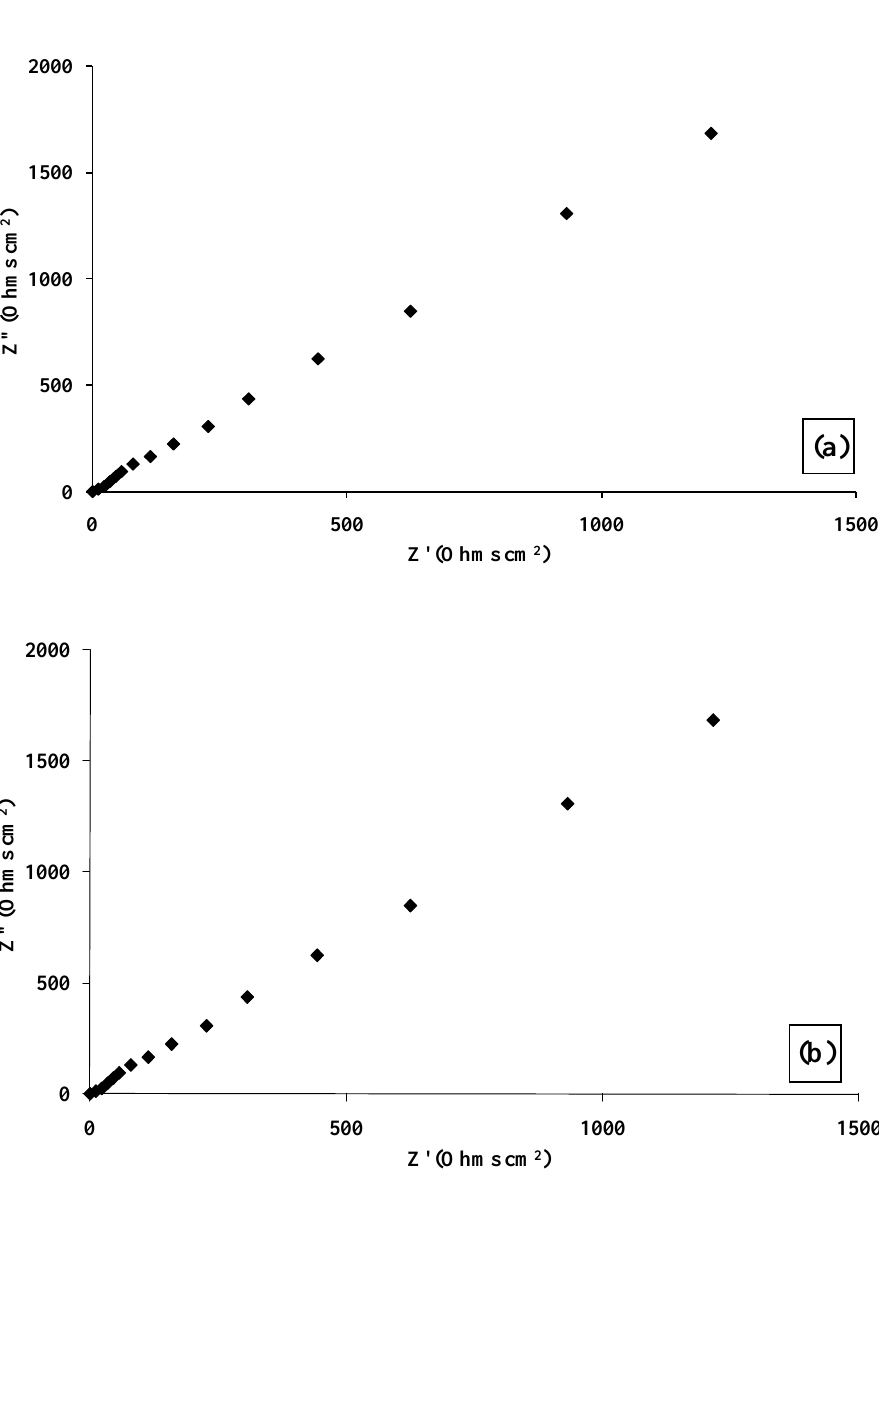
Figure 14. Plot of real versus imaginary impedance for a poly(aniline)/alcohol oxidase microelectrode array exposed to ethanol (40 mM) under (a) aerobic and (b) , anaerobic conditions. Plot of phase angle versus frequency for a poly(aniline)/alcohol oxidase microelectrode array exposed to ethanol (40 mM) under (c) aerobic and (d) anaerobic conditions: ( ) 0 mM; ( ) 1 mM; ( ) 5 mM; (×) 10 mM; (*) 20 mM; ( ) 30 mM; (+) 40